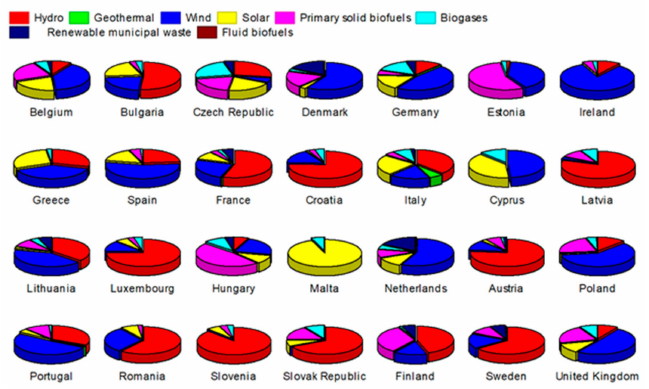
Figure 8. Structure of energy production from renewable energy sources per 1 km 2 of area of individual EU countries in 2017 (own study based on data from [37]).